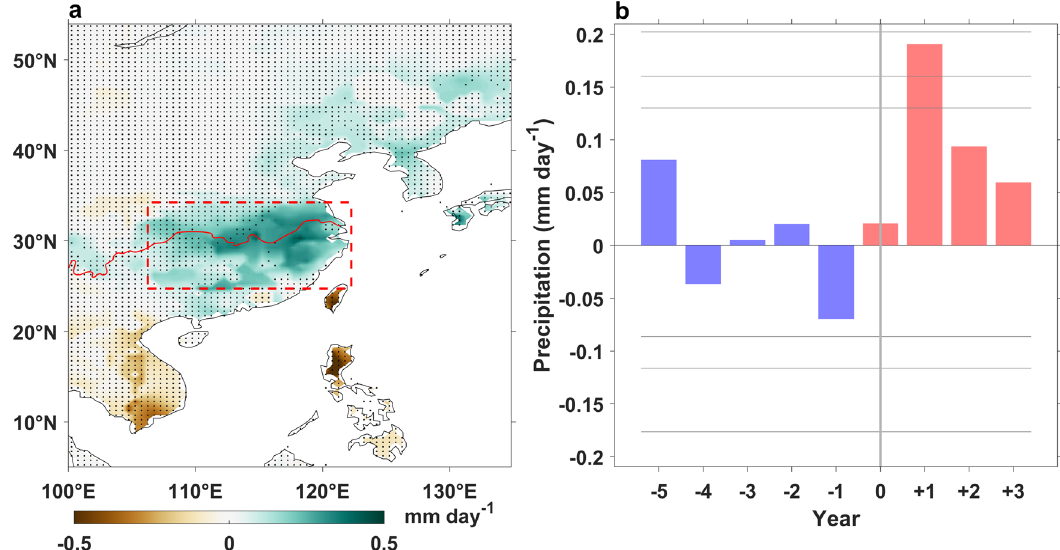
Fig. 1 East Asian summer monsoon (EASM) response to tropical eruptions based on reconstructions. a Superposed epoch analysis results of East Asian precipitation anomalies (shading) in the fi rst boreal summer after 22 tropical eruptions from 1470 to 1999 AD. Stippling indicates precipitation anomalies not signi fi cant at the 90% con fi dence level. The red curve is the Yangtze River, and the red box indicates the EASM region (25° – 34°N, 106° – 122°E). b Composite EASM-averaged precipitation anomaly for 22 tropical eruptions. Con fi dence limits (90, 95, and 99%) are marked by horizontal lines. Red and blue colors mark the post-eruption and pre-eruption composites, respectively. Year 0 denotes the eruption year. This fi gure was created using MATLAB 2020a (http://www.mathworks.com).